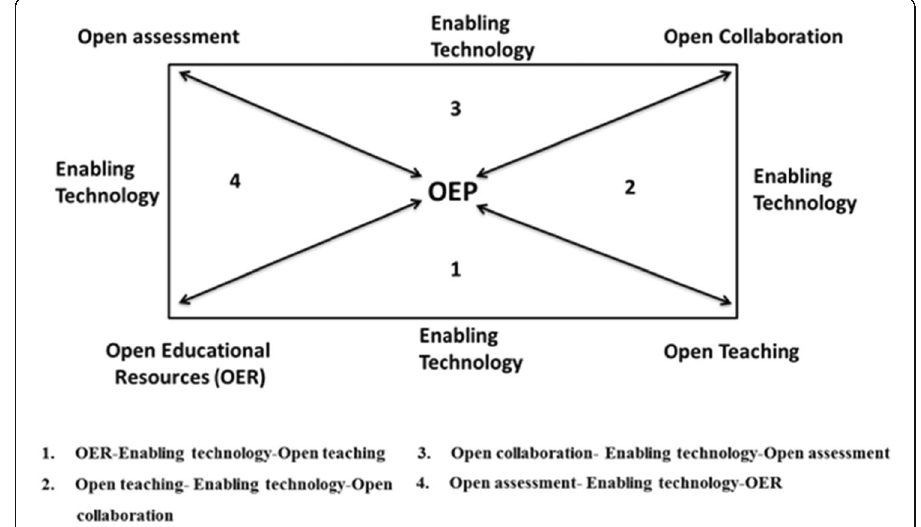
Fig. 1 OEP framework for open